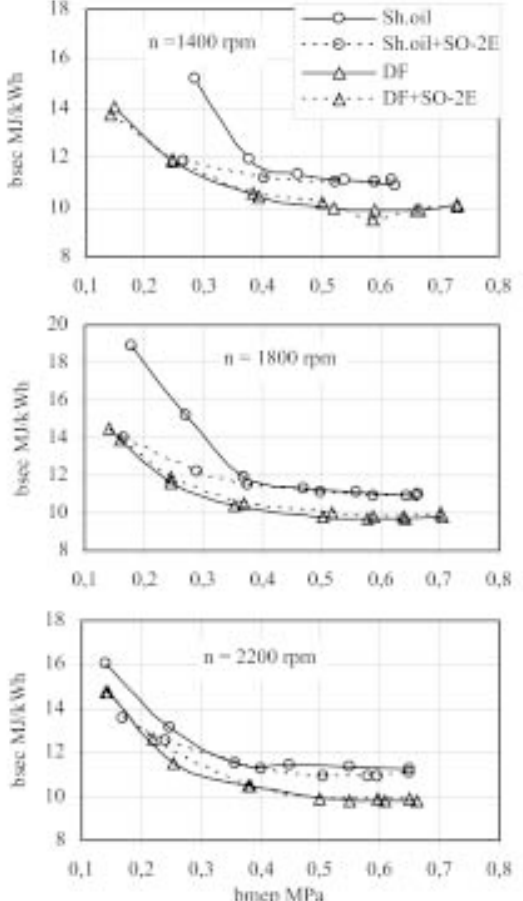
Fig 1 . The brake specific energy consumption (bsec) as a function of engine load (bmep) at various revolution